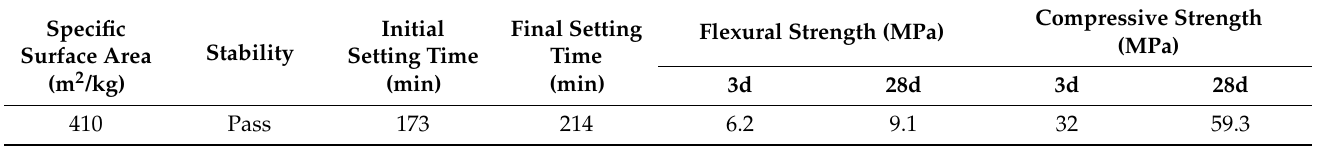
Table 5. Properties of Portland